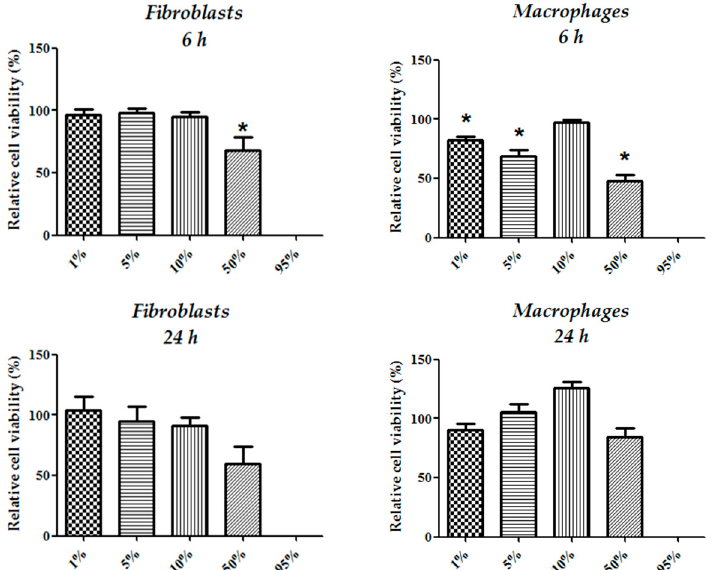
Figure 2. Assay of cell viability in fibroblast and macrophage cultures. MTT reduction was evaluated in fibroblast and macrophage cultures at 6 h and 24 h, respectively. Values represent the percentage of cell viability of cultures treated with CFEAS at different concentrations (1–95%) from the untreated control (mean ± SD). The treatment of fibroblasts and macrophages with 50 and 95% or 1, 5, 50, and 95% CFEAS, respectively, showed statistically significant differences when compared with untreated controls (* p ≤ 0.05).